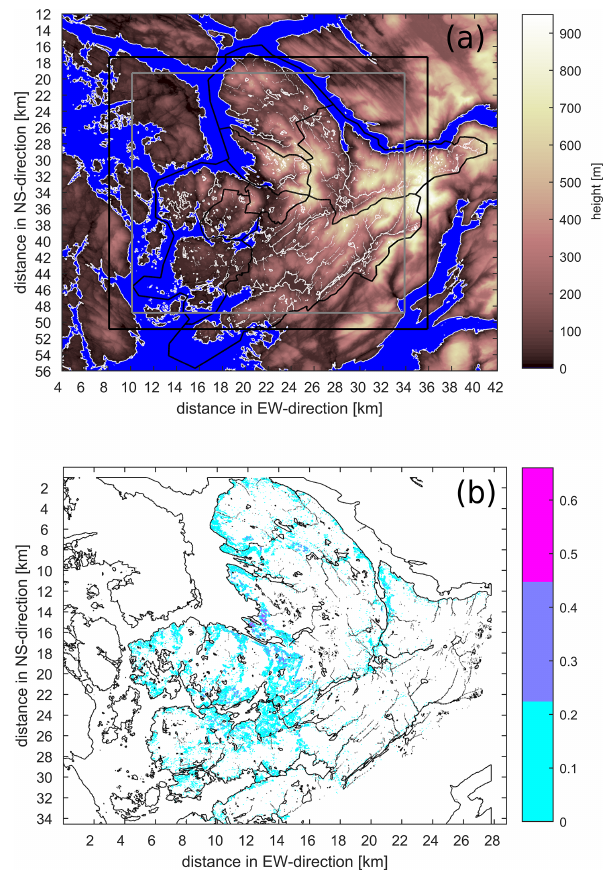
Figure 1. (a) Topographic map of the Bergen municipality. The color shading indicates elevations of the land surface area. Water surfaces are marked with blue color shading. The black curved lines indicate district boundaries. The black rectangle indicates the full extent of the model simulation domain. Buffer zones are not in- cluded. The grey rectangle indicates the part of the model domain that is selected for the analysis. (b) Map with the locations of wood- burning stoves in Bergen. The color shading indicates the num- ber of households with registered stoves per 10 × 10m 2 grid box (averaged over 3 × 3 boxes). Black lines indicate waterfront. Data sources are the Bergen municipality and the Bergen Fire